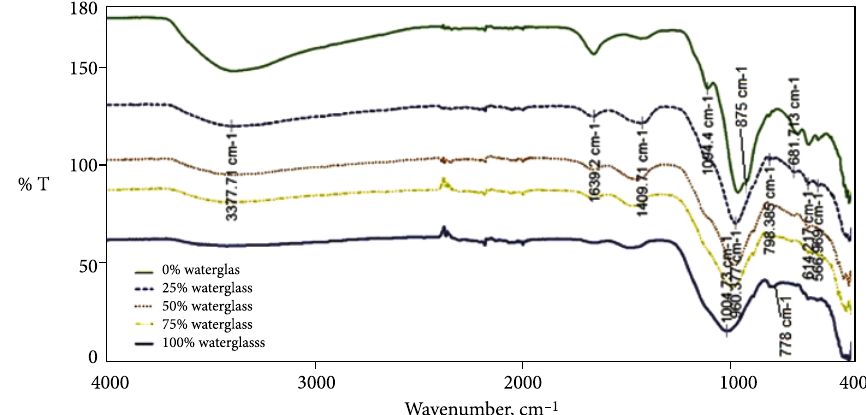
Fig. 7. FT-IR spectras of geopolymer prepared using water